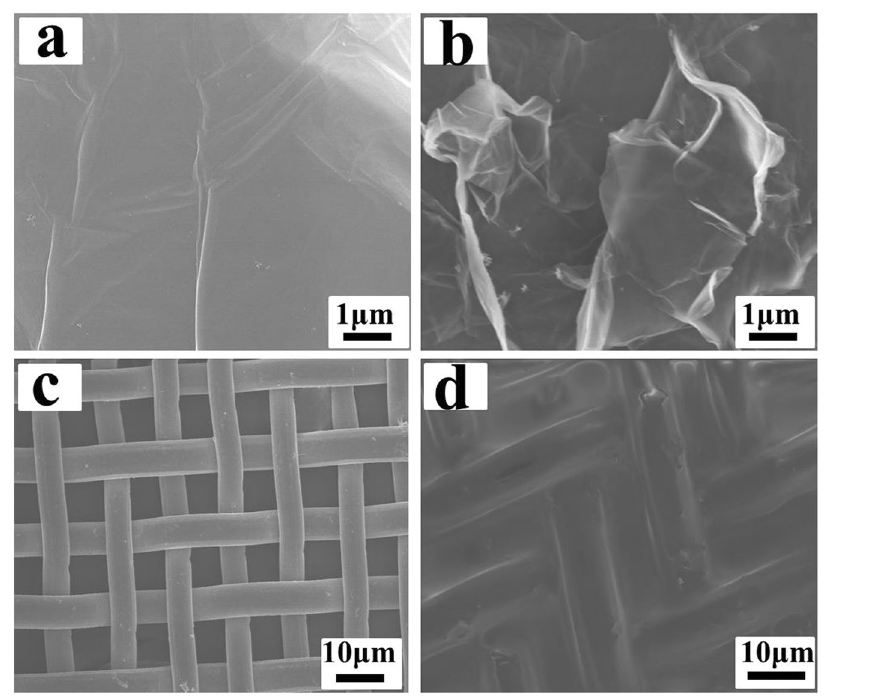
Figure 3. The SEM images of GO ( a ), PGO ( b ), CM ( c ) and CM@PGO ( d